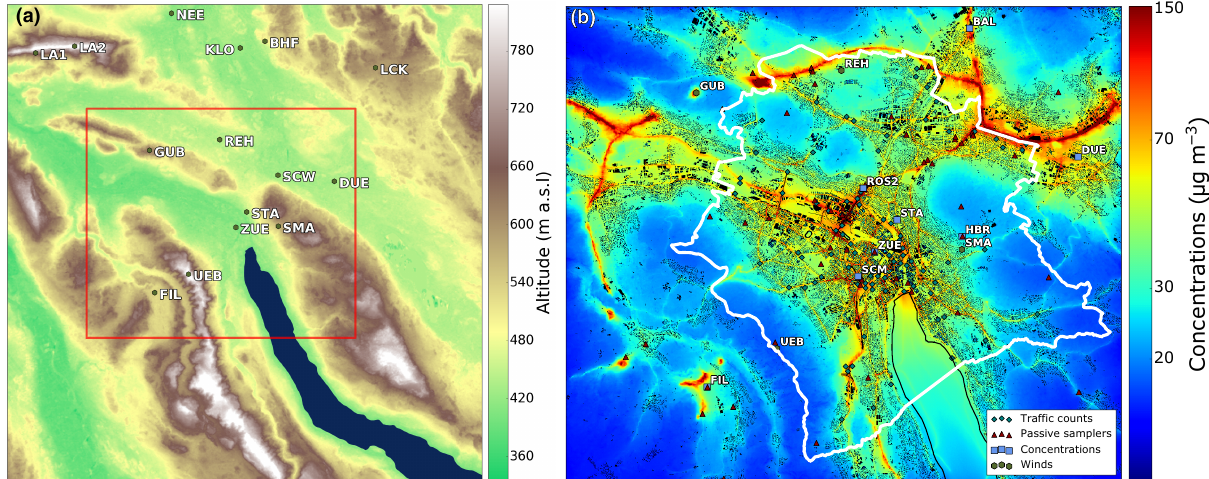
Figure 2. Simulation domains for the models GRAMM and GRAL. (a) GRAMM domain and wind measurement sites used in the match-to- observations procedure. The red rectangle is the domain covered by GRAL. (b) GRAL domain with in situ observation sites overlaid on the 2013–2014 average NO x concentrations as simulated by the modelling system. The political borders of the city are delimited by the white